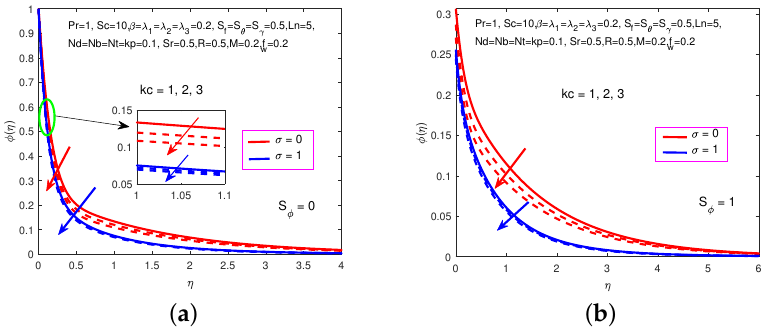
Figure 10. Influence of kc and σ on φ . ( a ) No solutal slip. ( b ) With solutal